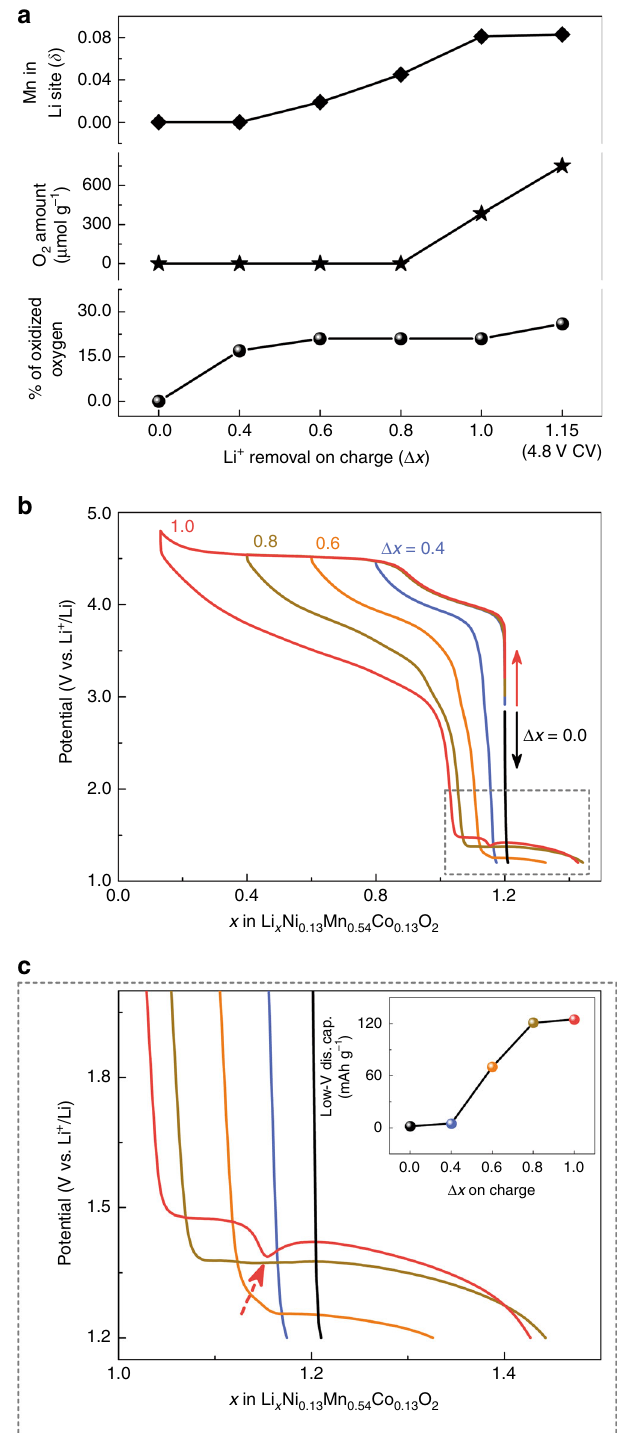
Fig. 4 Mn migration associated with the triggering of anionic redox on charge and its consequence of low-potential electrochemical activities.